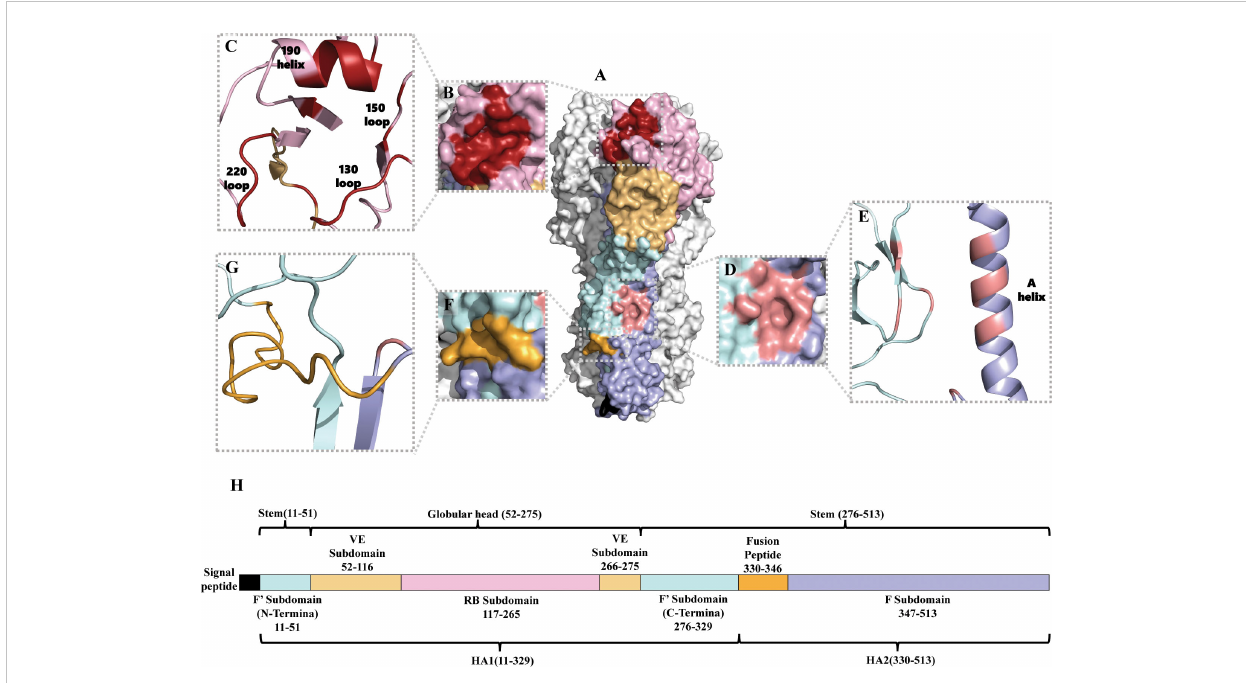
FIGURE 1 Structure of the HA of in fl uenza A virus. (A) Protein molecular model of H3 HA (A/Aichi/2/68). The RB subdomain is shown in pink, the RBS in dark red, the VE subdomain in yellow, the F ’ subdomain in bright blue, the F subdomain in light purple, the fusion peptide in orange-yellow, and the hydrophobic groove region in orange-red (29). (B, C) are the RBS surface and cartoon representation, respectively (30). (D, E) are the hydrophobic groove region surface and cartoon representation, respectively (31). (F, G) are the fusion peptide surface and cartoon representation, respectively (29). (H) Amino acid sequence of HA (H3 numbering)